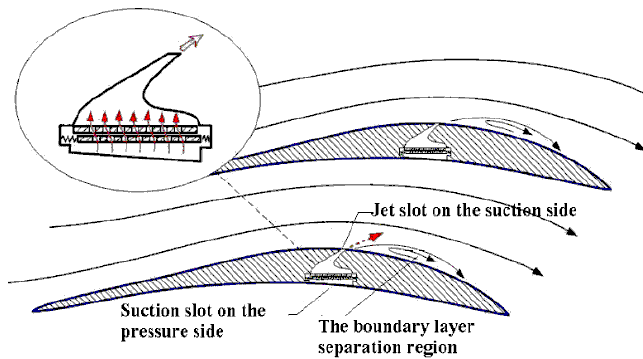
Figure 2. Schematic diagram of micro pulsed jet concept.